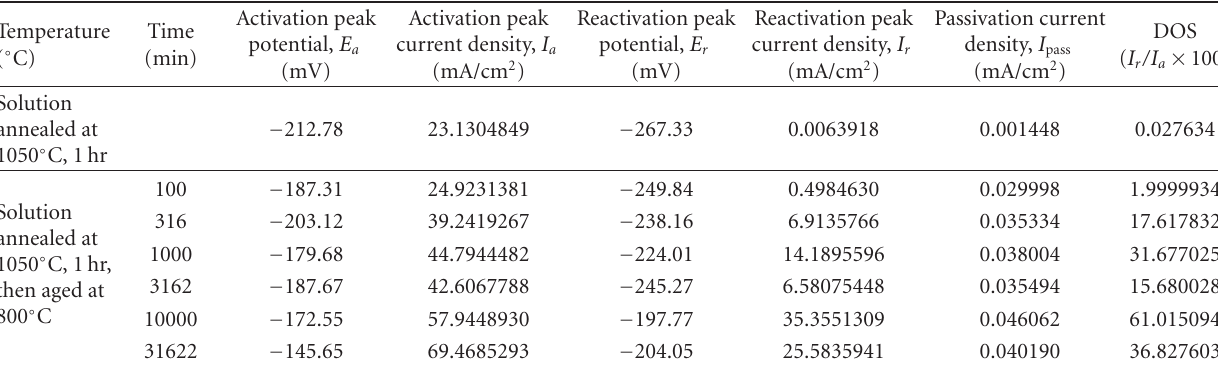
Table 5: DLEPR test results of 2205 type duplex stainless